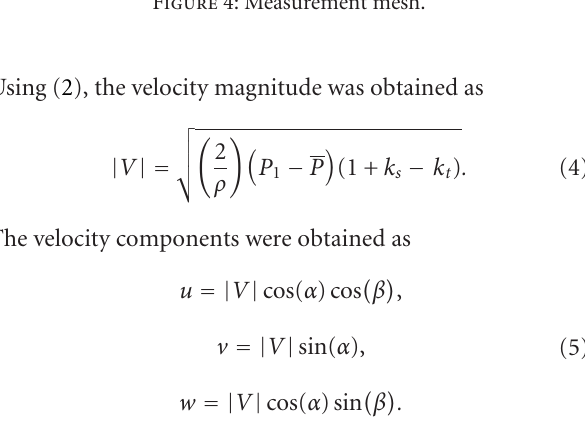
Figure 4: Measurement mesh.